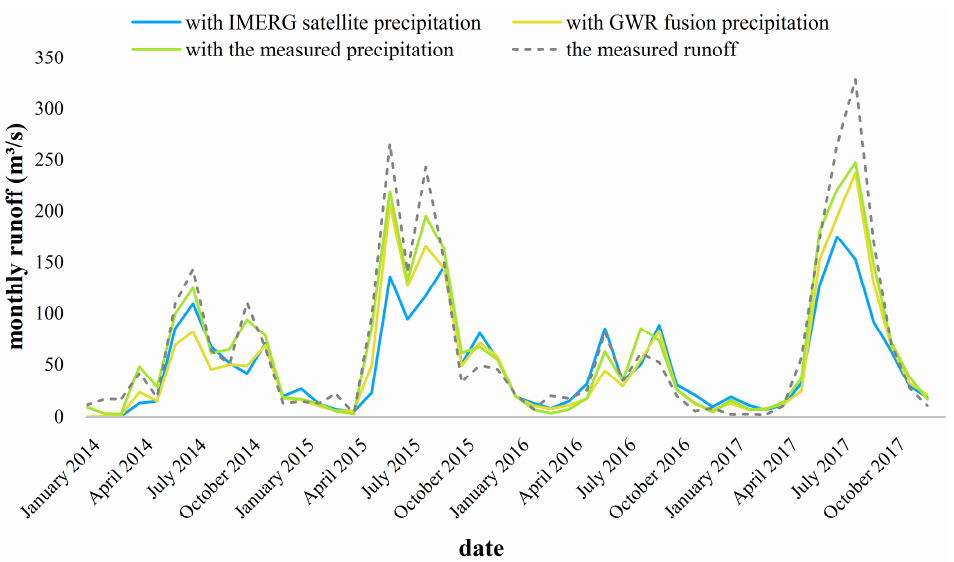
Figure 10. Monthly runoff simulation results of multi-source rainfall data.